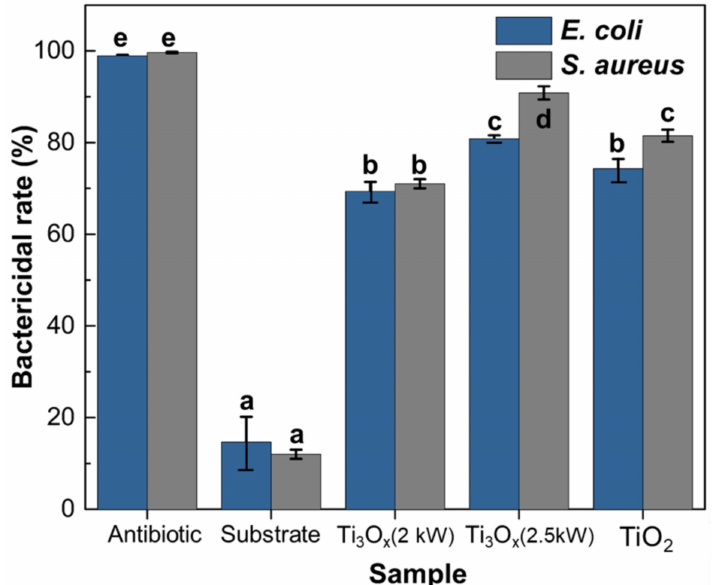
Figure 10. Effect of Ti 3 O x thin films on bactericidal activity against E. coli and S. aureu s compared to the substrate (negative control) and antibiotic (100 µ g/mL, positive control) after 60 min UV light irradiation treatment. Means denoted by a different letter indicate significant differences between treatments ( p < 0.05; Tukey HSD test). Data were expressed as mean ± standard deviation ( n =